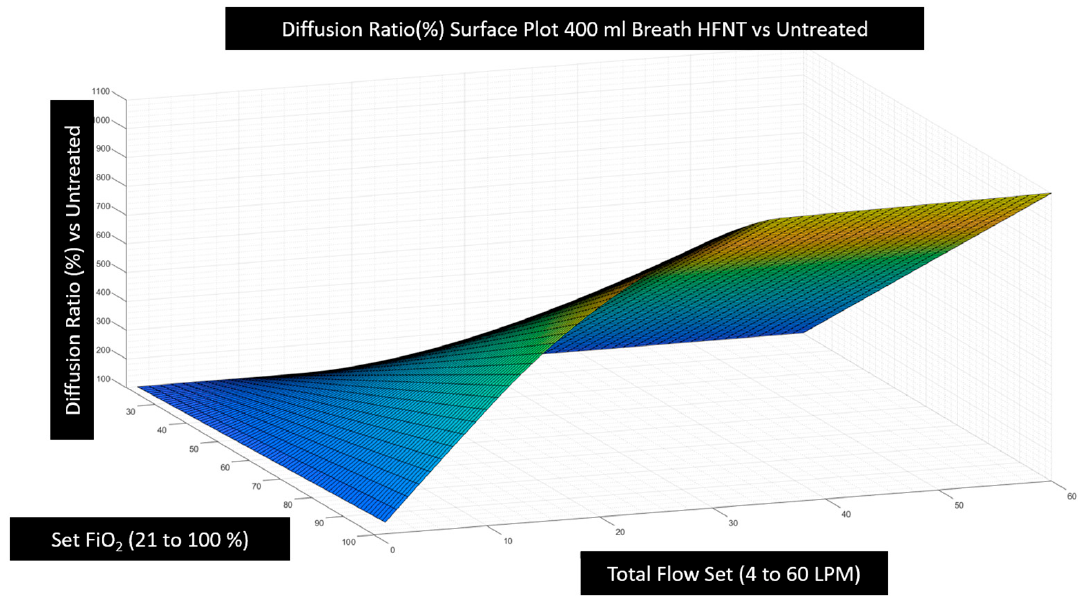
Figure 9. The rotated surface of Figure 8 illustrates how small the diffusion rate benefit is from the small additional PEEP described by Parke et al. [14] due to increasing flow. This is indicated because the surface is flat in the vertical dimension when the flow setting is above the PIF. The diffusion ratio increases as the flow setting is increased to the PIF (36 LPM here), and then, no more benefit at any F i O 2 setting is incurred from increasing flow above the PIF. This implies that increasing total flow above PIF is simply an unnecessary expenditure of oxygen supplies without perceived clinical benefit to the patient.